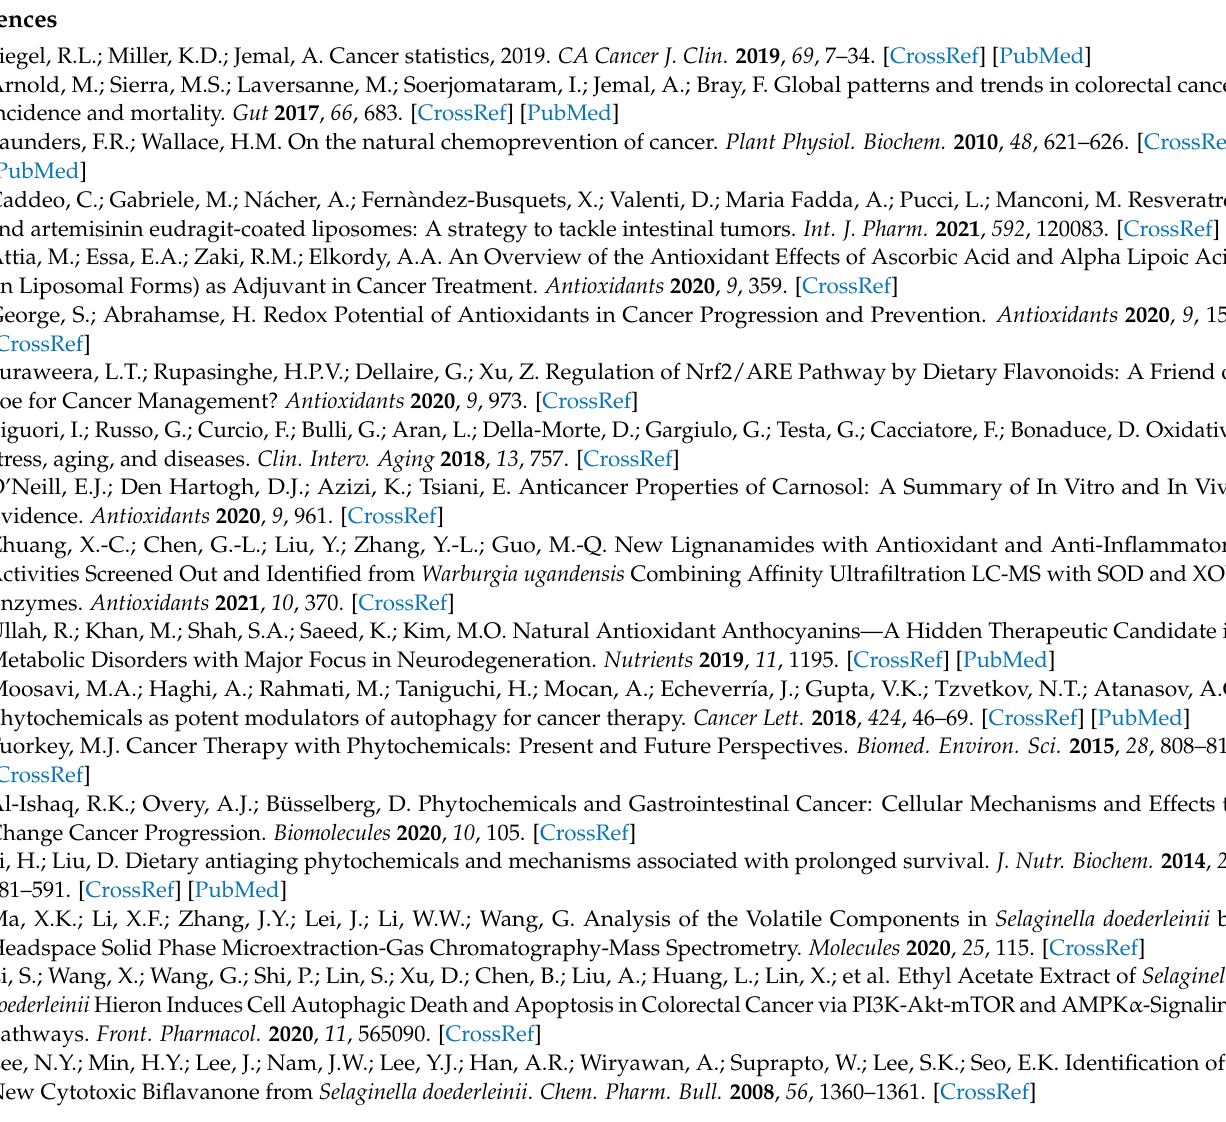
d 4, Figure S12. 13C NMR (150 MHz) spectrum of compound 3 in Methanol- d 4, Figure S13. DEPT (150 MHz) spectrum of compound 3 in Methanol- d 4, Figure S14. HSQC (600 MHz) spectrum of compound 3 in Methanol- d 4, Figure S15. 1H-1H COSY (600 MHz) spectrum of compound 3 in Methanol- d 4, Figure S16. HMBC (600 MHz) spectrum of compound 3 in Methanol- d 4, Figure S17. NOESY (600 MHz) spectrum of compound 3 in Methanol- d